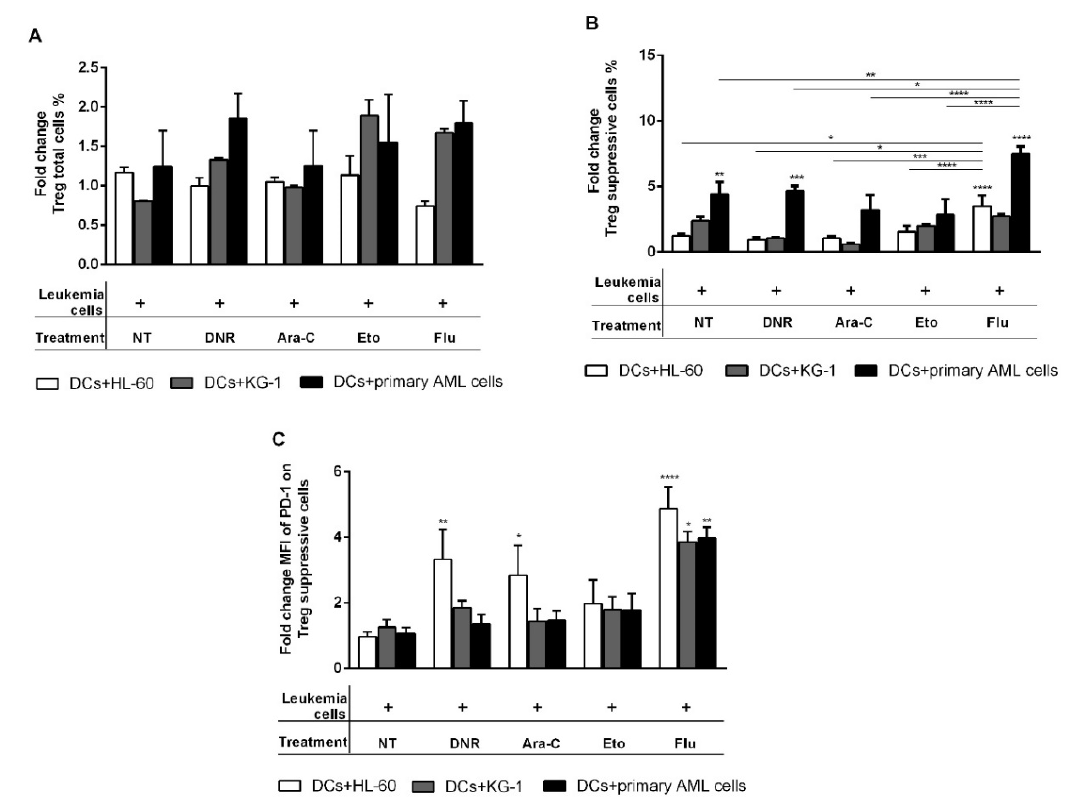
Figure 8. Flow cytometry analysis of T regulatory cells (Tregs) induced by dendritic cells (DCs) loaded with chemotherapy-treated HL-60, KG-1 and primary AML cells. The HL-60, KG-1 and primary AML cells were treated or not (no treatment; NT) with daunorubicin (DNR) (500 ng/mL), cytarabine (Ara-C) (20 µg/mL), etoposide (Eto) (20 µg/mL) and fludarabine (Flu) (70 µg/mL) for 4 h and loaded in immature DCs (immDCs) for 24 h. After 24 h, un-loaded immDCs or DCs loaded with treated HL-60, KG-1 and primary AML cells were mixed with CD3 + T cells for 5 days. The Tregs phenotype was then analyzed by flow cytometry. ( A ) Induction of total Tregs was characterized as CD3 + CD4 + CD25 +/high CD127 -/low T cells and expressed as fold change. ( B ) Induction of suppressive subtype of Tregs was characterized as CD3 + CD4 + CD25 high CD127 -/low CD45RA - /FOXP3 +/high T cells and expressed as fold change. ( C ) Mean of fluorescence intensity (MFI) of programmed cell death protein 1 (PD-1) expressed on suppressive Tregs was expressed as fold change. The values are represented as mean ± SEM of 5/3/3 independent experiments for HL-60/KG-1/primary AML cells, respectively. CD3 cells stimulated with unloaded immDCs were used as reference and set as 1. * p < 0.05; ** p < 0.01; *** p < 0.001; **** p < 0.0001 compared to CD3 cells stimulated with un-loaded immDCs.